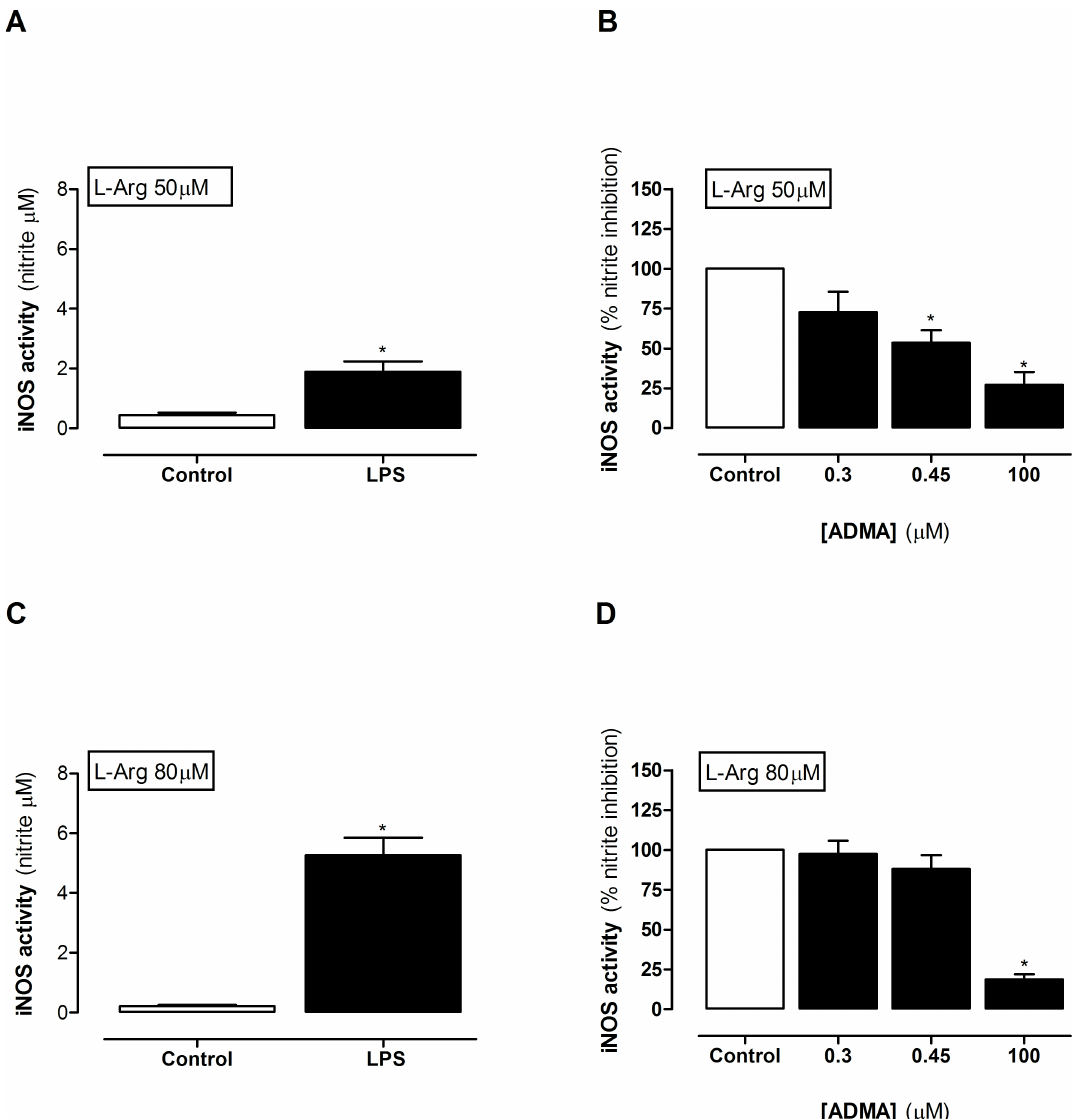
Fig 3. iNOS activity in LPS-activated mouse macrophages treated in culture media. iNOS activity in macrophages was measured in cells cultured in the presence of (A,B) 50 μ Mor (C,D) 80 μ M L-arginine. Data are ± SEM for n = 4–6. Data was analysedby (A,C) pairedt-test and (B,D) one-wayANOVA with Dunnett’s post-hoc test. * p <